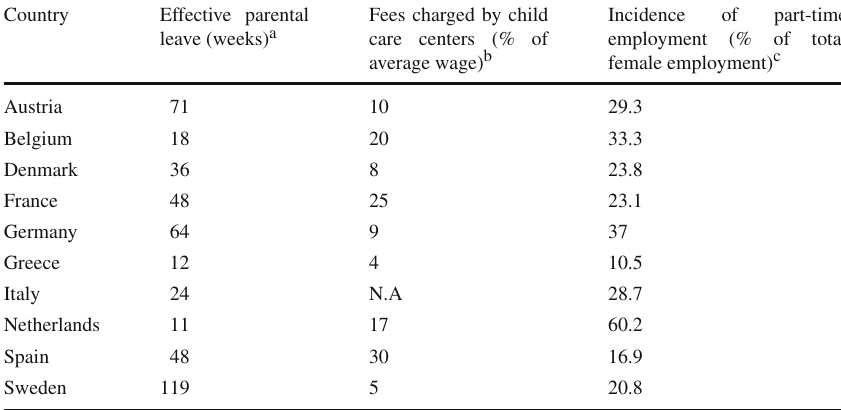
Table 2 Family leave policies, cost of child care and labor market characteristics